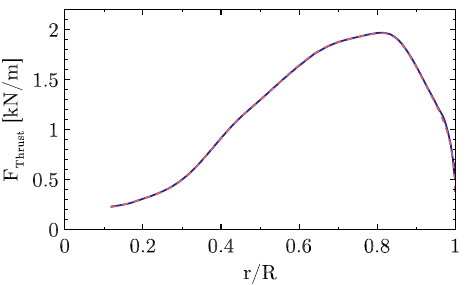
Figure 5. Influence of the grid resolution on the sectional thrust force. Standard medium mesh (dashed), refined grid (solid).